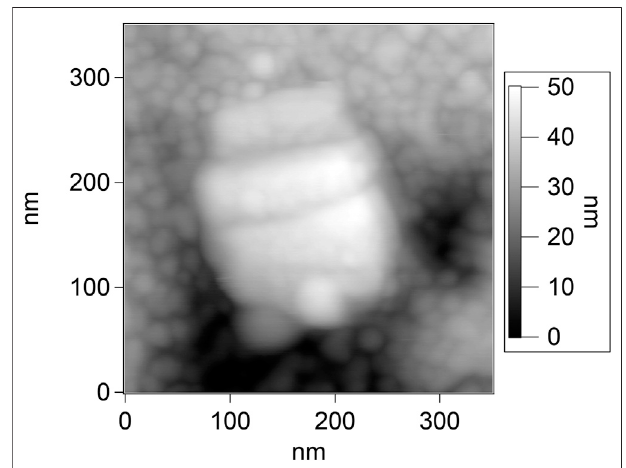
FIGURE 11 | Large particle inside an agglomeration of wear particles at the reversal point of a wear